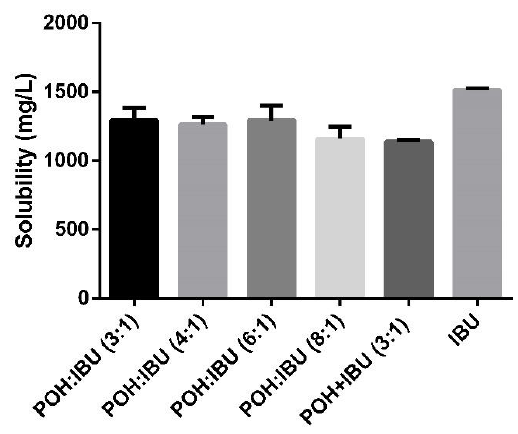
Figure 5. Solubility of IBU in powder form or complexed in THEDES in a PBS solution at physiological-like conditions.